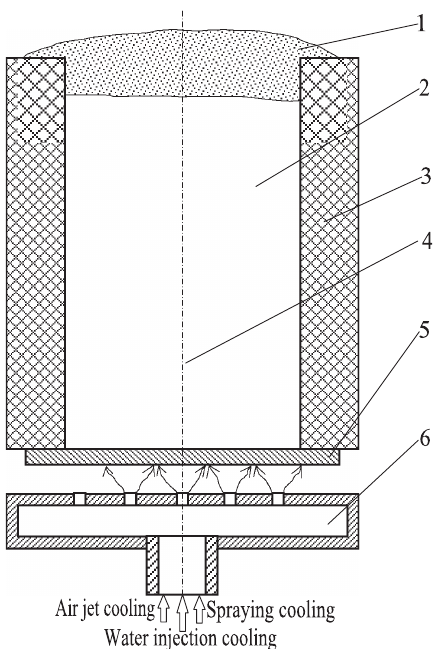
Figure 1: Fundamentals schematic plan of preparing Cu-Al composite casting using pouring aluminum: (1) covering agent for thermal retardation; (2) Al liquid; (3) casting mold; (4) thermal couple; (5) copper plate; (6) cooler.